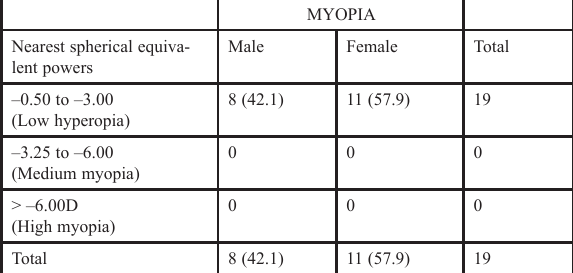
Table 2 Distribution of low, medium and high negative refractive pow- ers (F NSE ) among the male and female subjects (percentages in brackets). All the powers were low myopia types ≤ −3.00 D. MYOPIA Nearest spherical equiva- lent